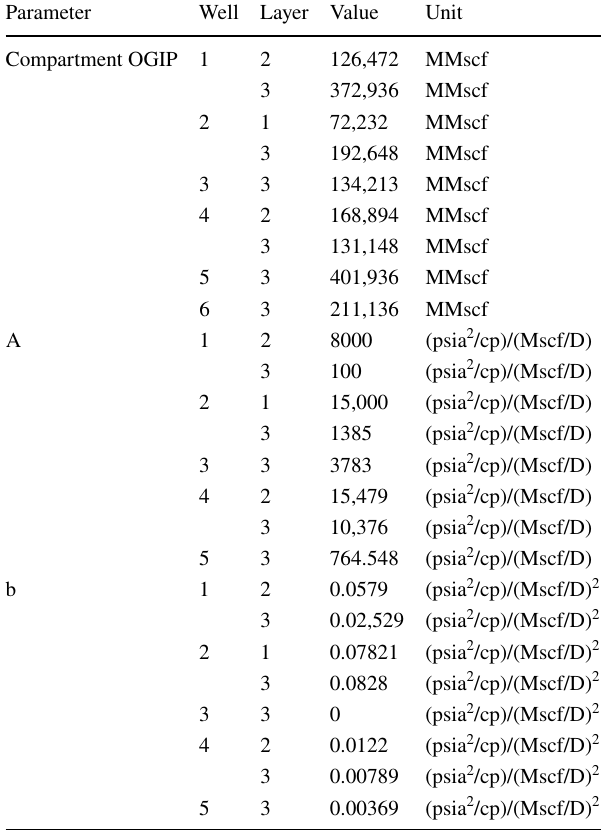
Table 6 Matching parameters for field case 2 Parameter